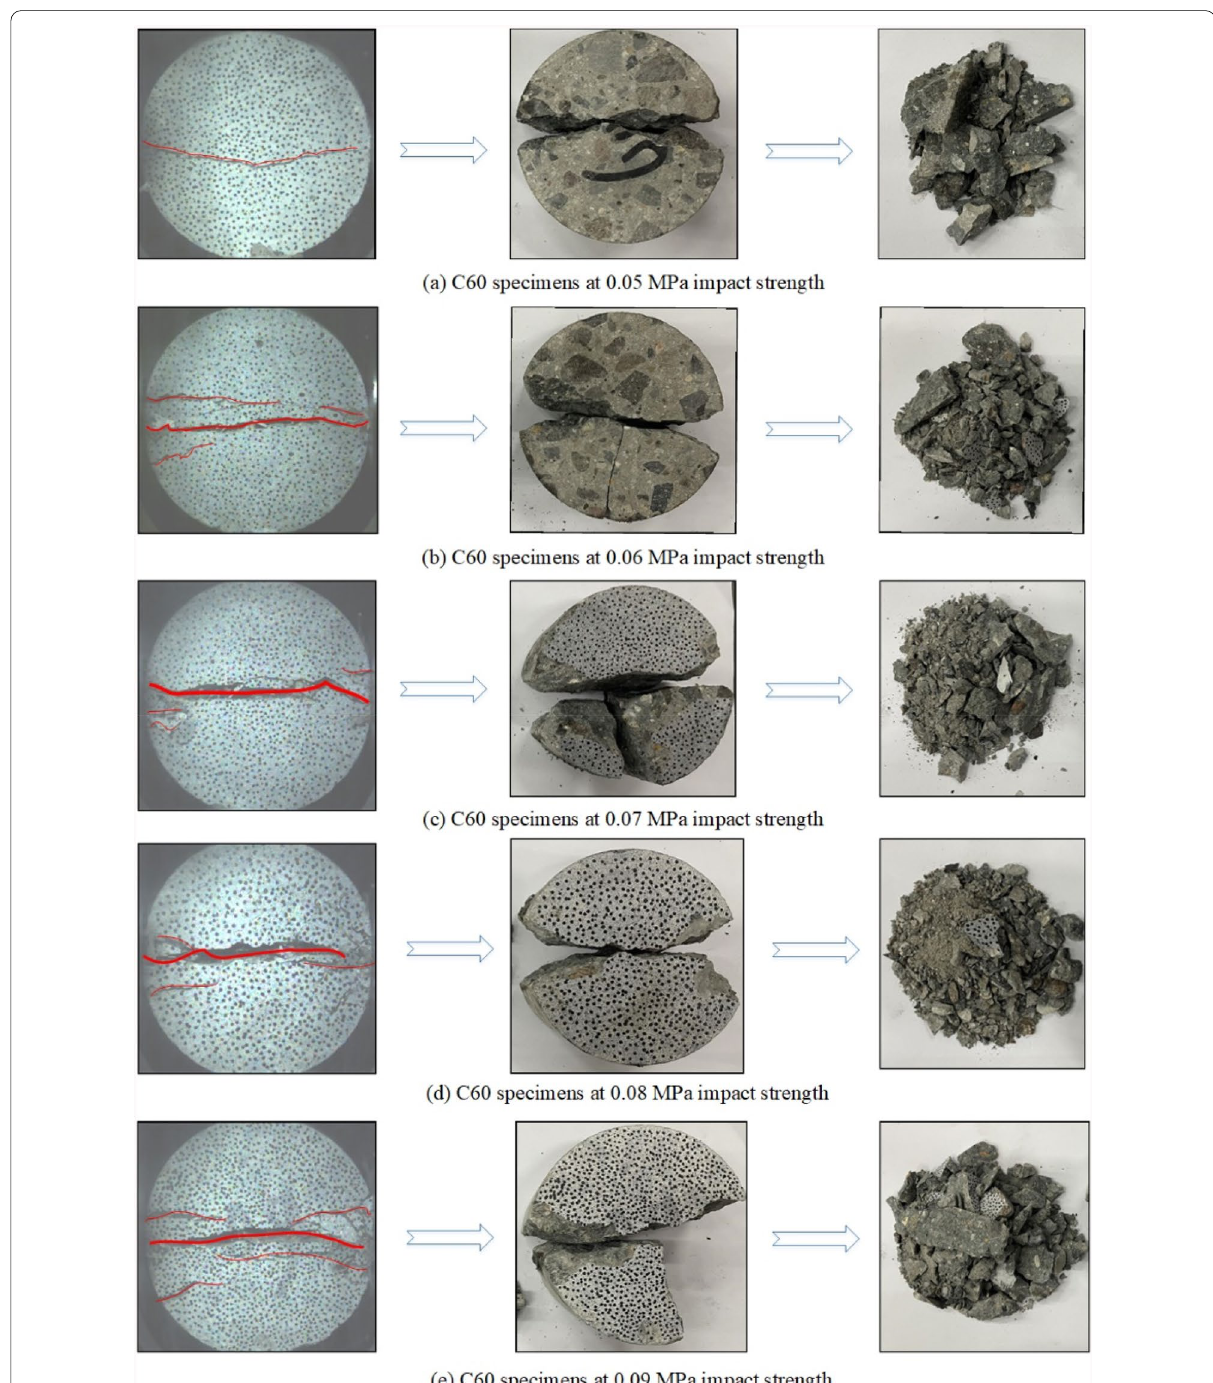
Fig. 4 Damage patterns of C60 concrete specimens at different impact